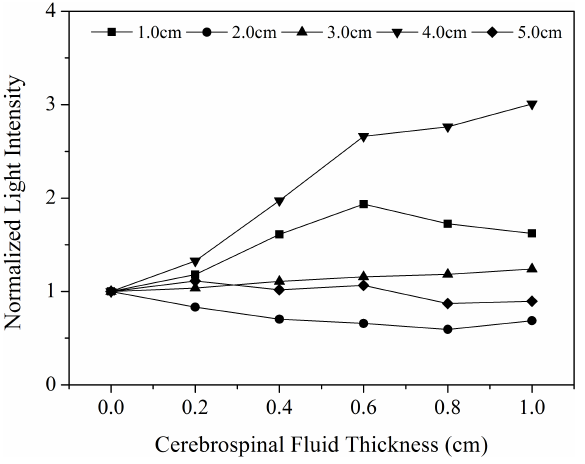
Fig. 5. Normalized light intensity with the CSF thickness at di®erent detecting radius.